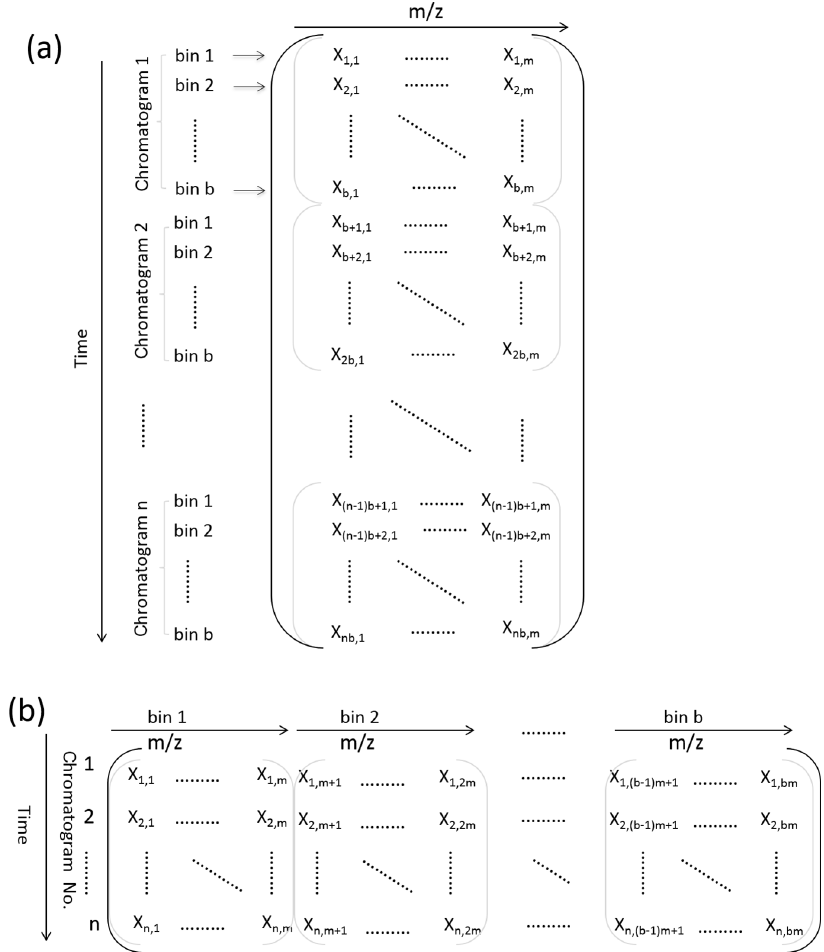
Figure 1. PMF data matrices of (a) the binning method for deconvolution of chromatograms and (b) source apportionment. The parameter n is the chromatogram number for each hour, b is the bin number, and m is the index of mass spectrum m/z .